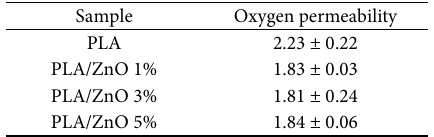
Table 4. Oxygen permeability rate in poly-lactic acid films containing nano-zinc oxide with different